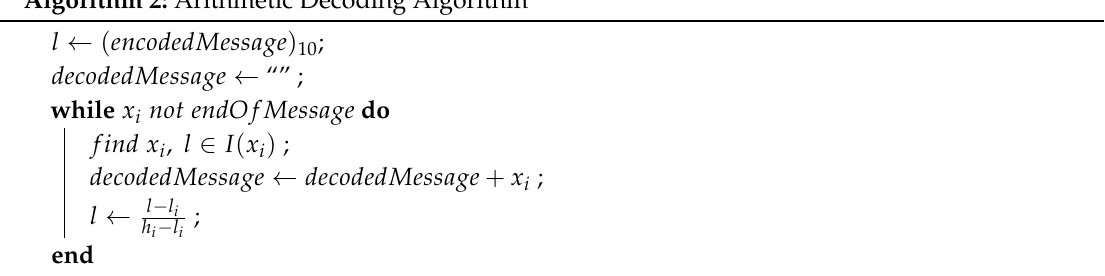
Algorithm 2: Arithmetic Decoding Algorithm